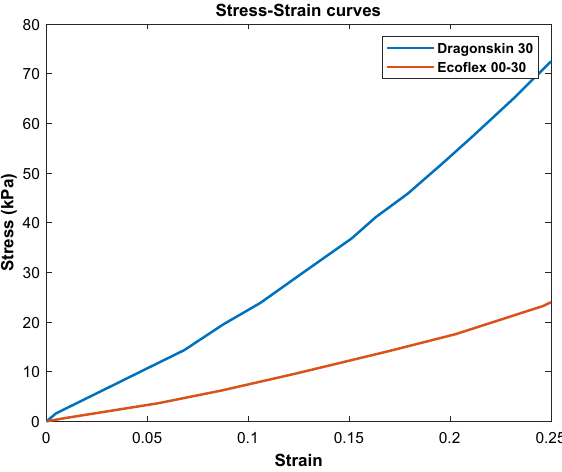
Figure 4. Stress–strain curve of Ecoflex 00-30 and Dragon skin 30.